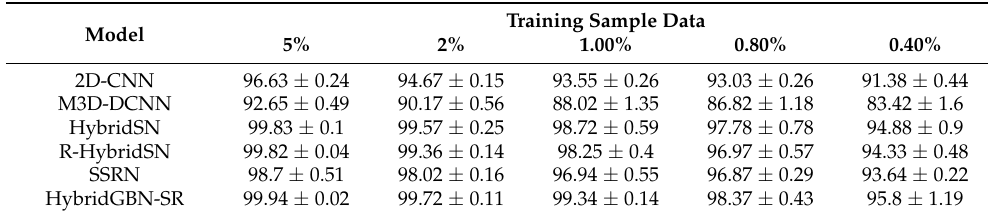
Table 9. The effect of varying the training sample data for the SSRN, Hybrid, R-HybridSN, and HybridGBN-SR models on the overall accuracy (OA) over the SA dataset.